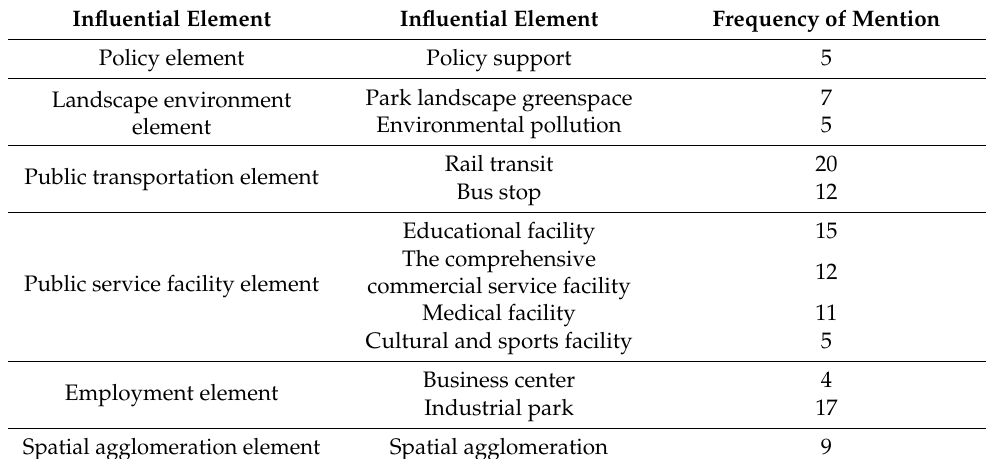
Table 4. Influential elements set of affordable housing site selection in the preliminary